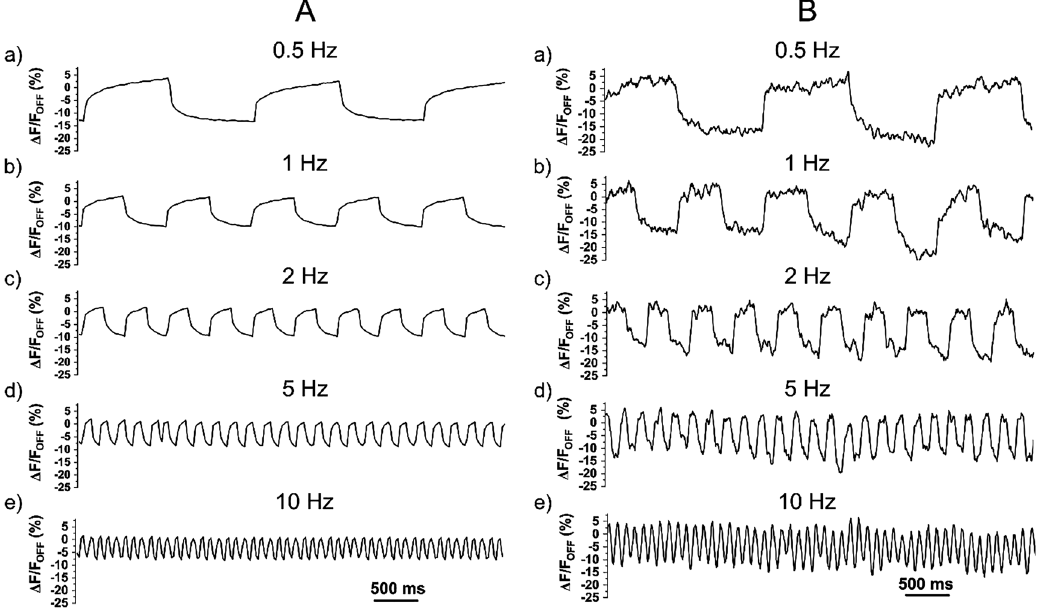
Figure 5: Effect of a frequency modulated E-field with an amplitude of 150 kV/cm on the fl uorescence changes of the quasi-type-II QD9-PSMA under (A) 1P excitation (460 – 495 nm) and (B) 2P excitation (900 nm) for different